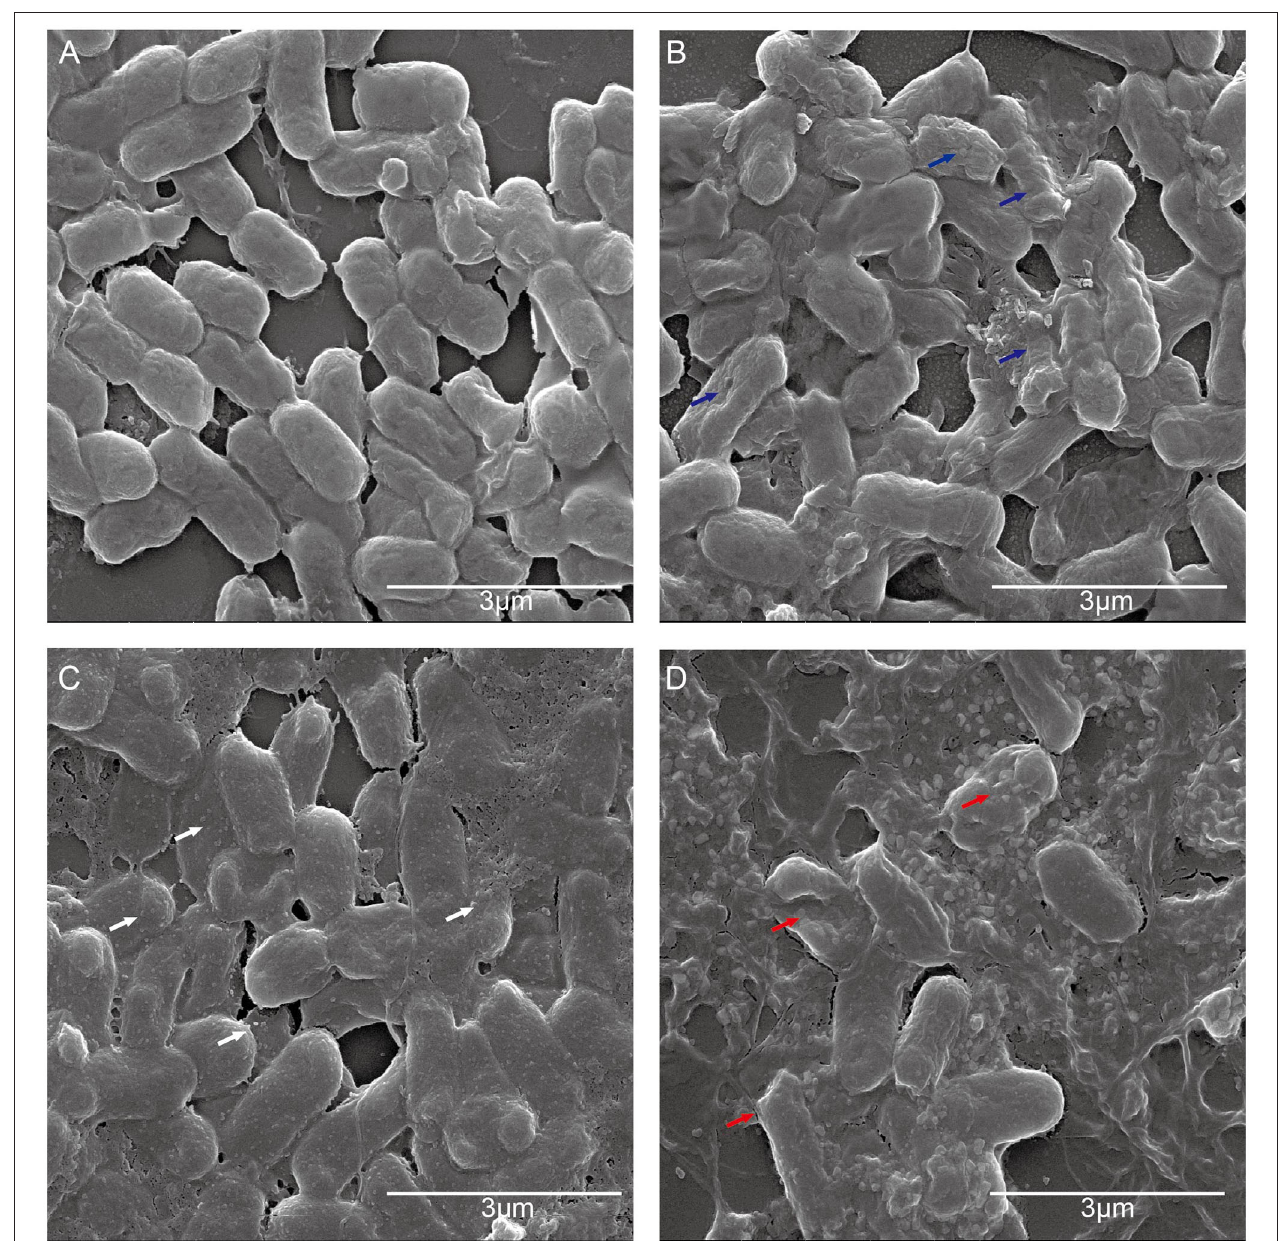
FIGURE 4 | The effect of CATH-1 and erythromycin combination on E. coli morphology. E. coli cells were grown to the mid-logarithmic phase and then treated with CATH-1 and erythromycin. After treatment, SEM was performed to observe bacterial morphology. (A) Untreated E. coli . (B) 1/16 MBC CATH-1-treated E. coli .